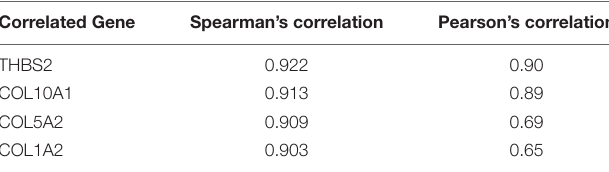
TABLE 1 | The correlation among the genes associated with COL11A1 gene in colorectal cancer. Correlated Gene Spearman’s correlation Pearson’s